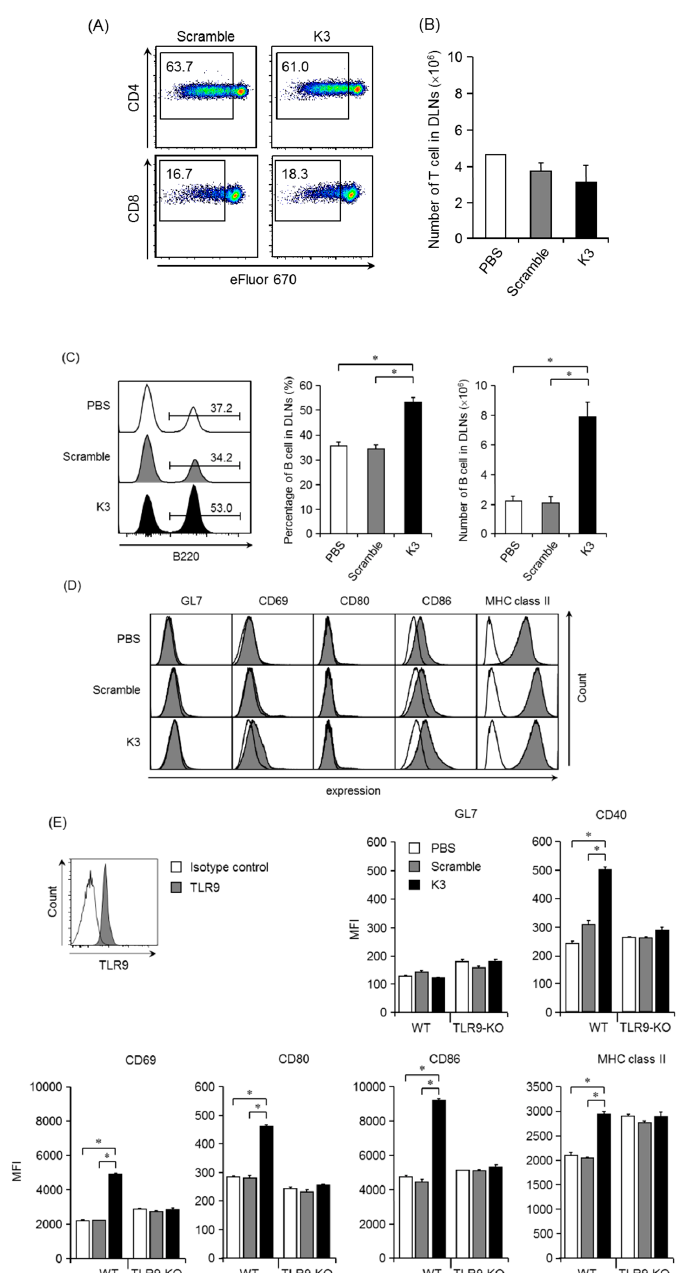
Figure 5. Characteristics of K3 in a transcutaneous vaccine formulation. WT mice (CD45.2, CD90.2) were intravenously transferred with eFluor 670-labelled OT-I (CD45.2, CD90.1) or OT-II cells